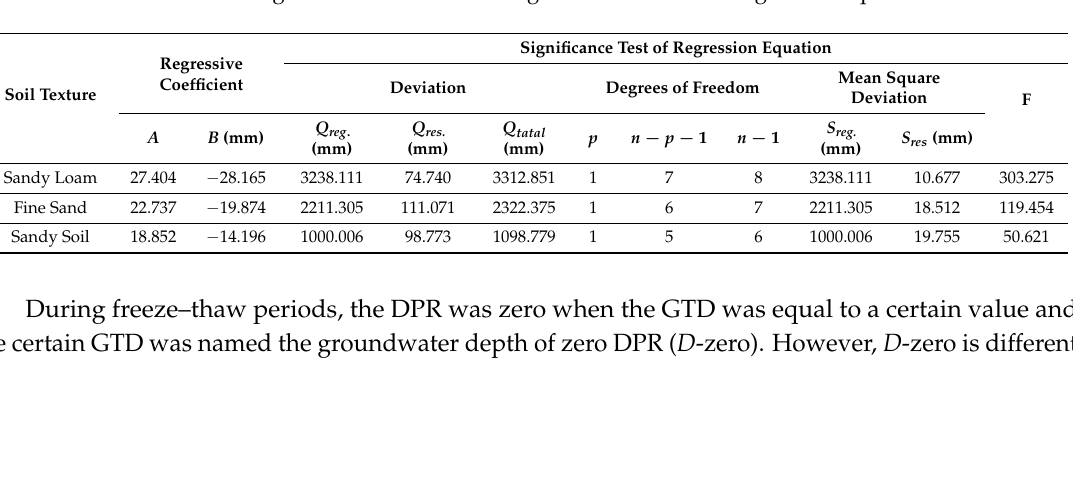
Figure 4. Fitting curves between the difference between phreatic evaporation and recharge to groundwater (DPR) and GTDs during freeze–thaw periods ( a ) sandy loam; ( b ) fine sand; and ( c ) sandy soil. Table 13. The regression coefficient and significance test of the regression